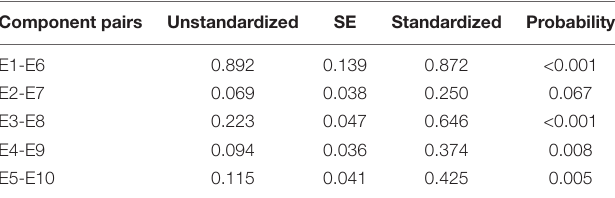
TABLE 4 | Covariances of error components of indicators of latent perceiver effects in similarity judgments and metaperceptions. Component pairs Unstandardized SE